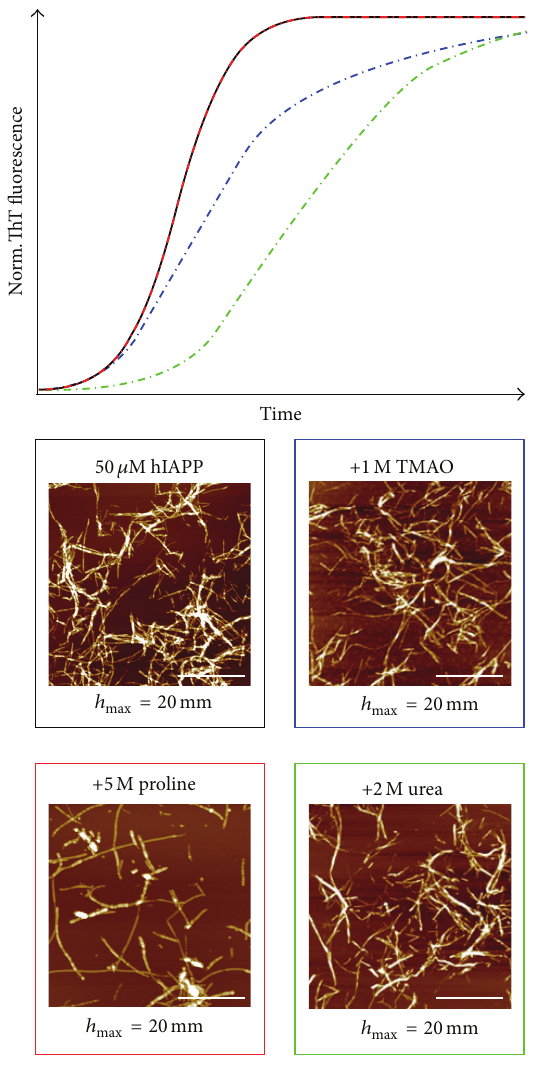
Figure 8: Effect of various osmolytes on the aggregation kinetics and morphology of hIAPP. Schematic summary of ThT fluorescence assays shows the effect of TMAO (blue), proline (red) and urea (green) on the aggregation kinetics of hIAPP. The corresponding effect on the morphology of the mature fibrils is studied by AFM. All scale bars indicate 1 𝜇 m. Adapted and modified from [152, 170] with permission from the Royal Society of